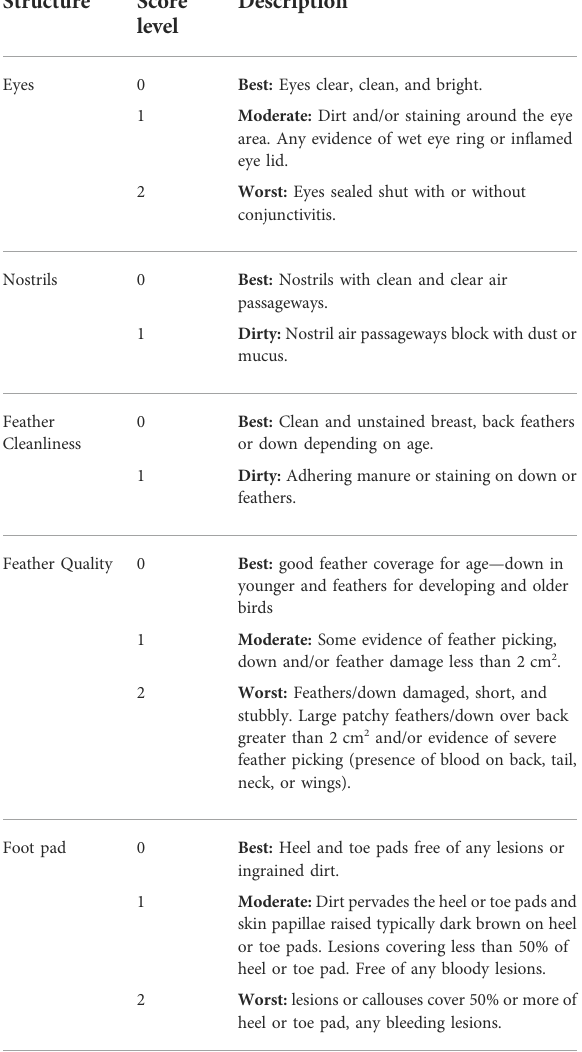
TABLE 1 Body condition scoring rubric for welfare assessment a